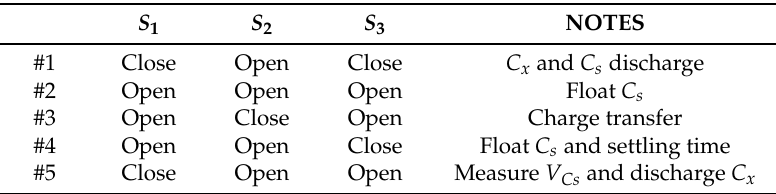
Table 2. Sequence diagram of the self capacitance sensor circuit.